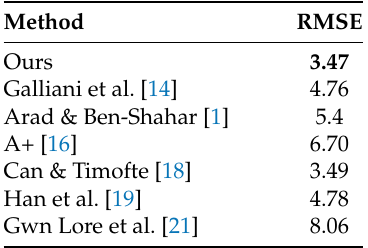
Table 2. Comparison with state-of-the-art approaches on CAVE